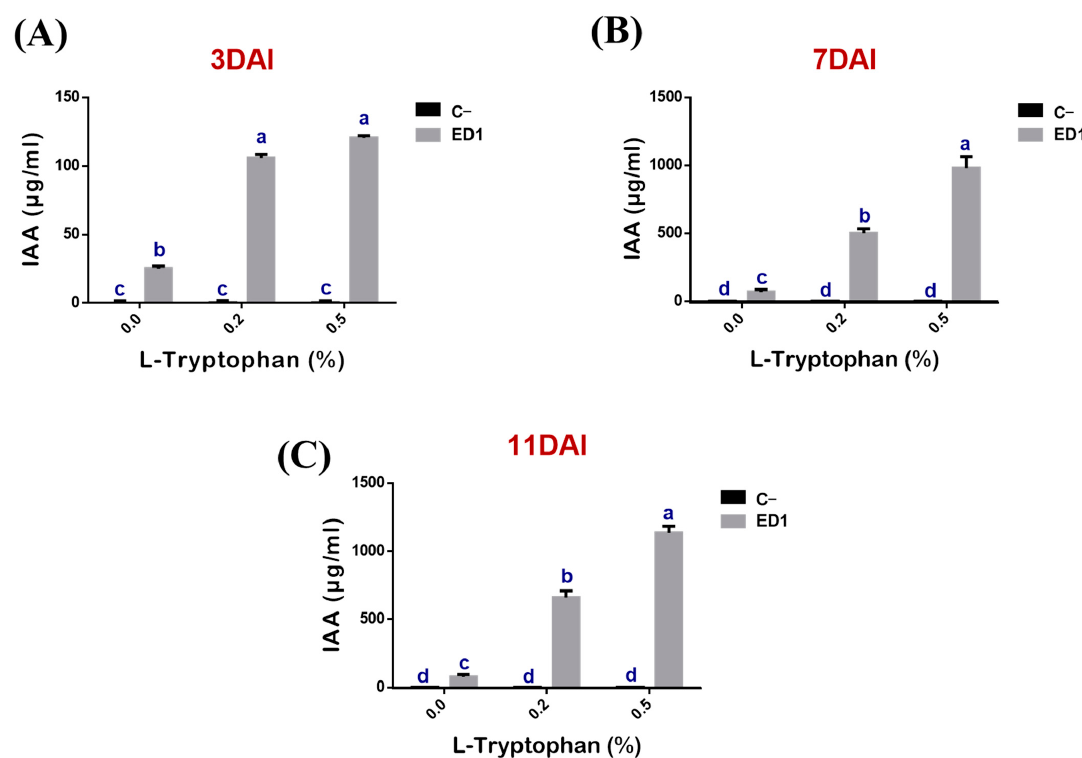
Figure 5. Kinetic of indole acetic acid (IAA) production by S. rubidaea ED1 with or without L-tryptophan addition. IAA determination was performed after 3 ( A ), 7 ( B ), and 11 ( C ) days of incubation. Uninoculated media were used as a negative control (C − ). The values represent means of three replicates ( n = 3) ± SD. The different letters in superscript (a–d) indicate the statistically significant difference at 95% between treatments.